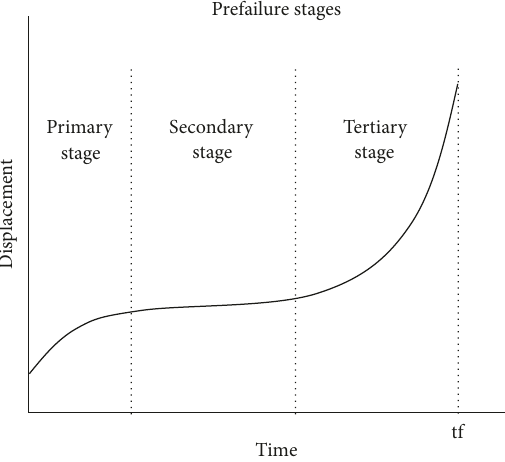
Figure 1: Primary stages of prefailure evolution.